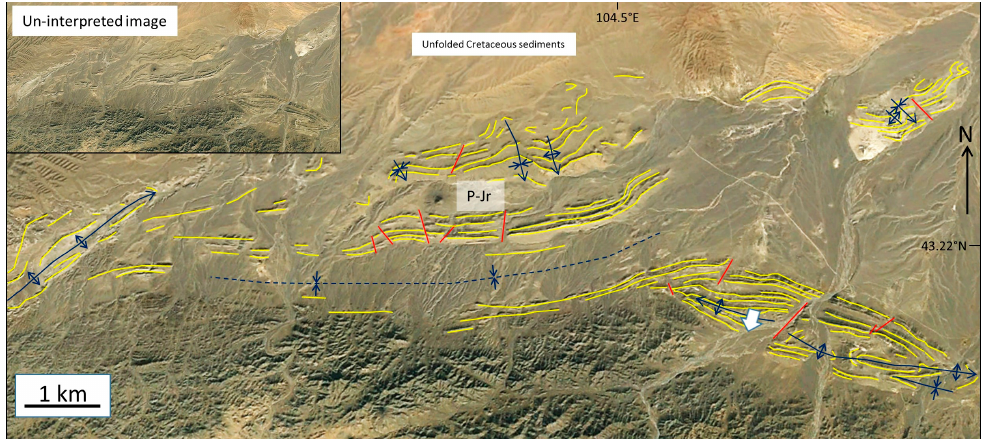
Figure 10. Google Earth image interpretation (2016, CNES Spot Image) showing bedding traces (yellow lines) and major fold hinges in folded Permian-Jurassic (P-Jr) sequence, 30 km east of Khurmen, easternmost Gobi Altai. Thick white arrow indicates direction of fold vergence. Inset shows un-interpreted scene. See Figure 1 for location.